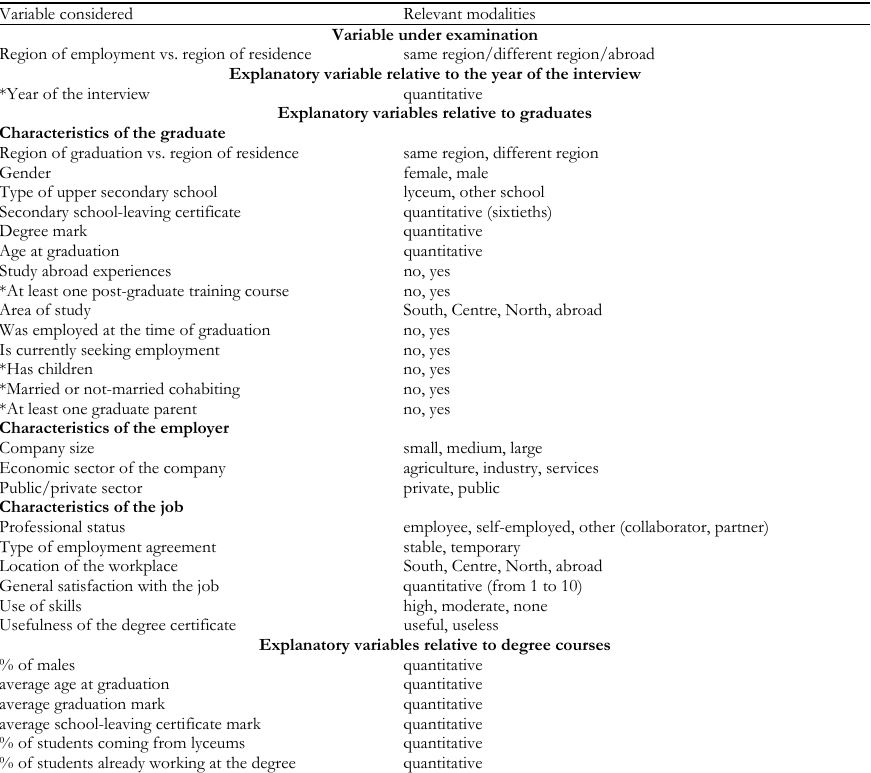
First, second and third-level variables employed in the three-level model Variable considered Relevant modalities Variable under examination Region of employment vs. region of residence same region/different region/abroad Explanatory variable relative to the year of the interview *Year of the interview quantitative Explanatory variables relative to graduates Characteristics of the graduate Region of graduation vs. region of